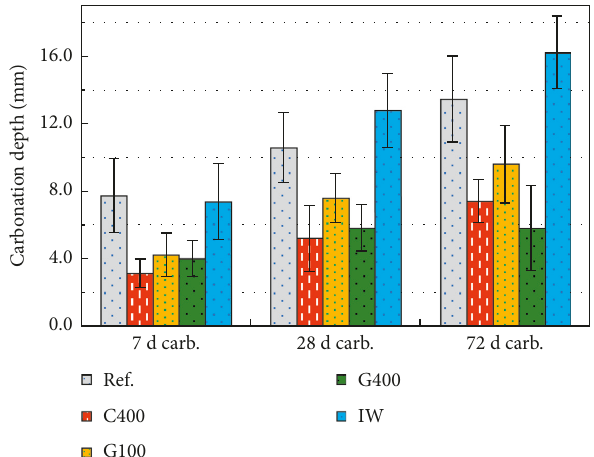
Figure 2: Carbonation depth of water repellent-treated and -un- treated concrete after 7, 28, and 72 days of accelerated